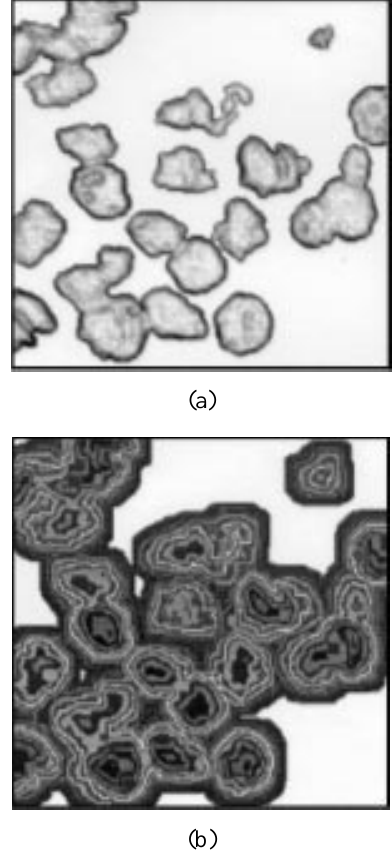
Fig. 4. (a) Potential surface by gradient map of an image slice after noise cleaning. (b) Potential surface by distance map of an image slice.